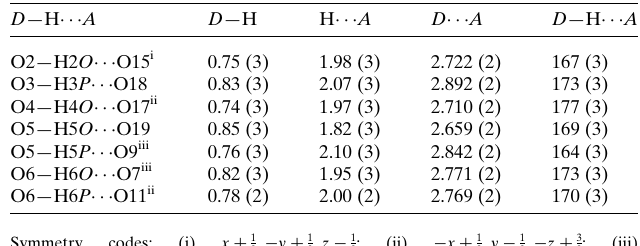
Table 1 Hydrogen-bond geometry (A˚ , (cid:3)